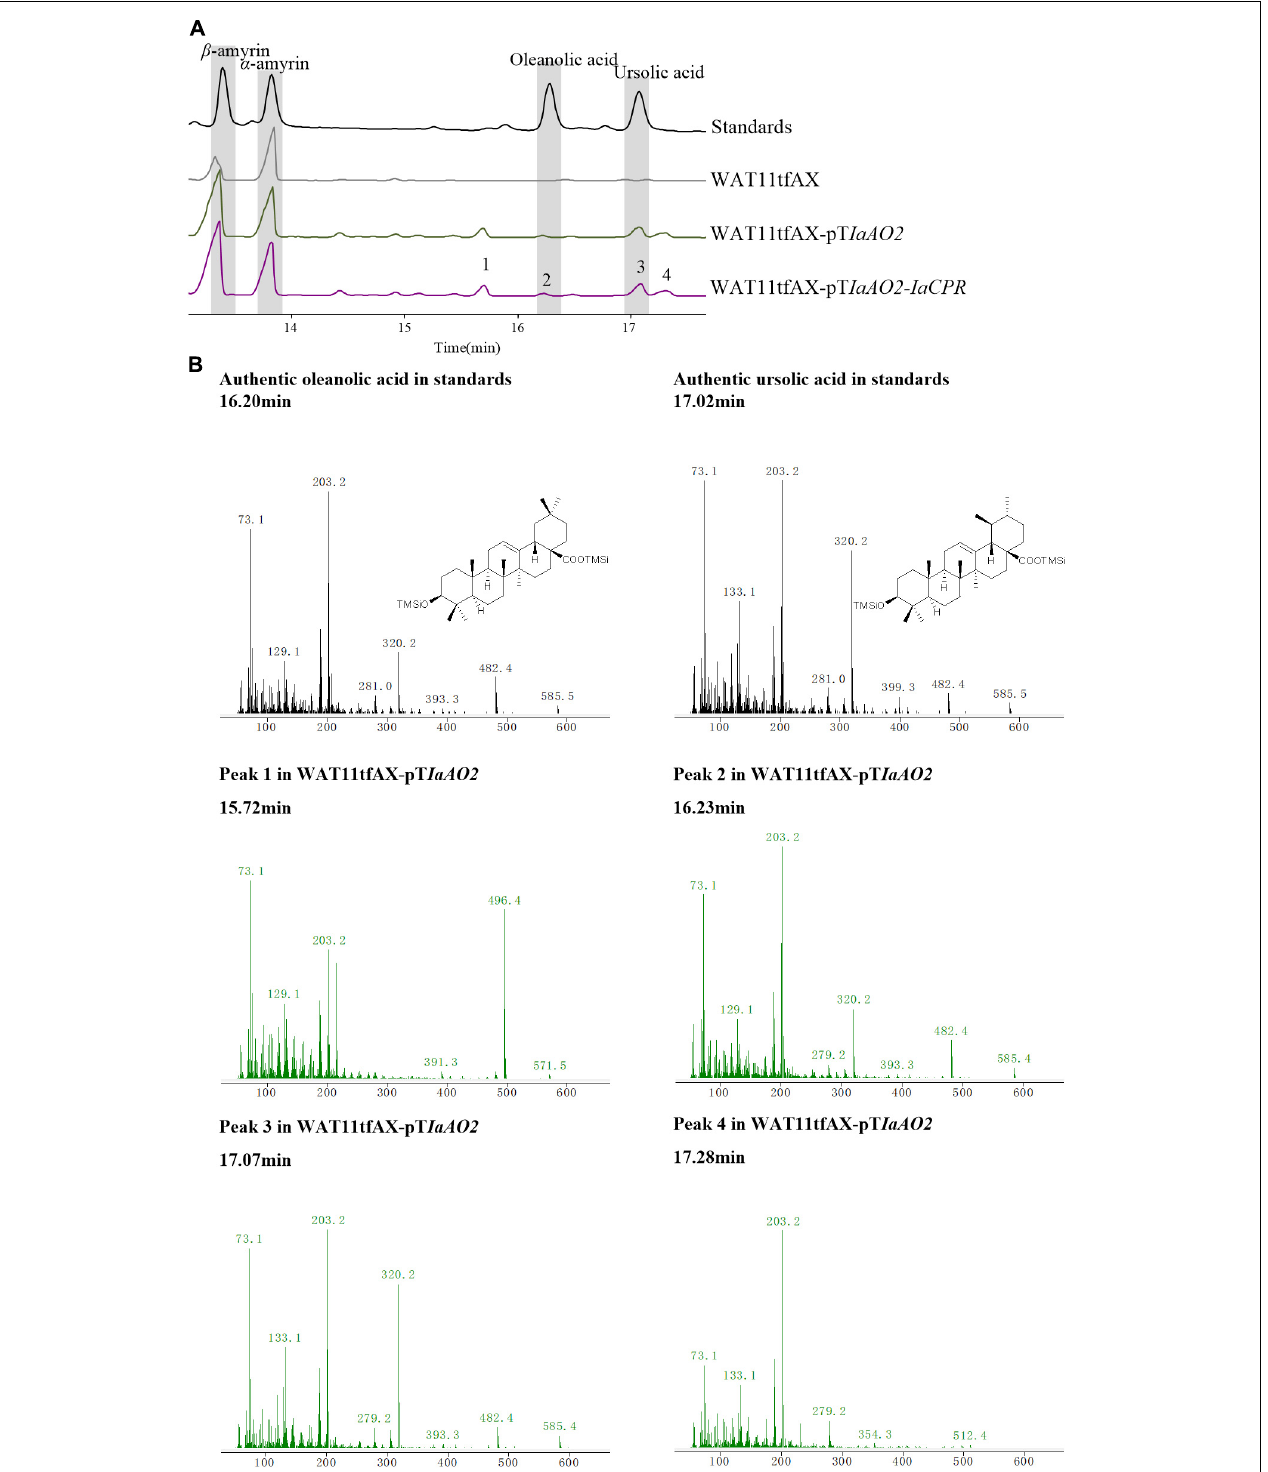
FIGURE 4 | GC-MS analysis of metabolites in WAT11tfAX-pT IaAO2 . (A) Total ion chromatograms of mixed standard (black line), WAT11tfAX (gray line), WAT11tfAX-pT IaAO2 (green line), and WAT11tfAX-pT IaAO1 - IaCYP (purple line). Major peaks were numbered. (B) Mass spectrum of ursolic acid, oleanolic acid and peak 1–4 from the GC profile shown in panel (A) . The retention time and mass spectra of peak 2 compared well with those of oleanolic acid. The retention time and mass spectra of peak 3 compared well with those of ursolic acid. The chemical structure shown were TMS-derivatized. GC-MS analysis was performed with a HP-5MS